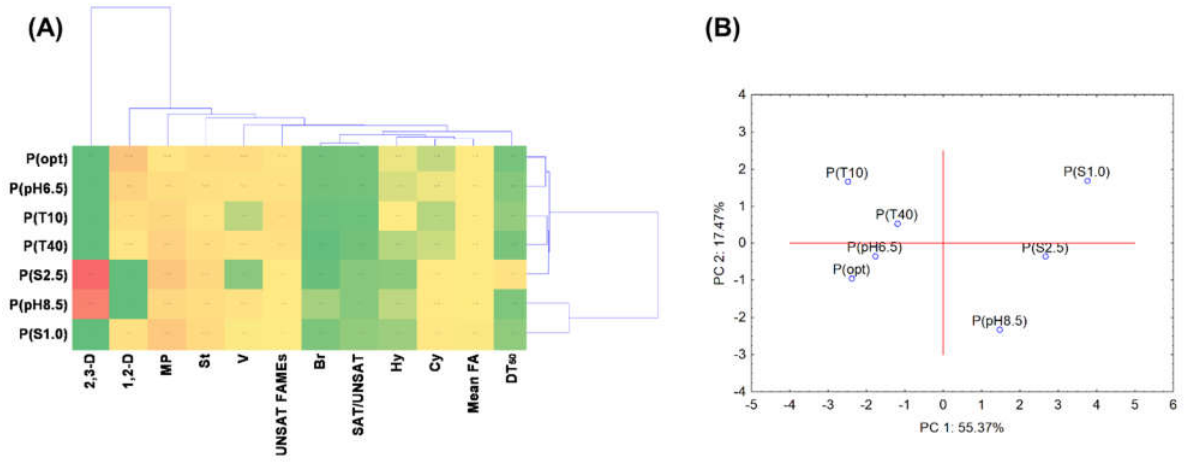
Figure 6. Projection of cluster analysis dendrograms ( A ) and PCA analysis biplots ( B ) for P. moorei KB4 under different culture conditions. Table 6. Pearson's correlation matrix for phenol degradation kinetic parameters, catechol 2,3-diox- ygenase activity, membrane permeability, and FAME indexes for P. moorei KB4 under suboptimal growth conditions.